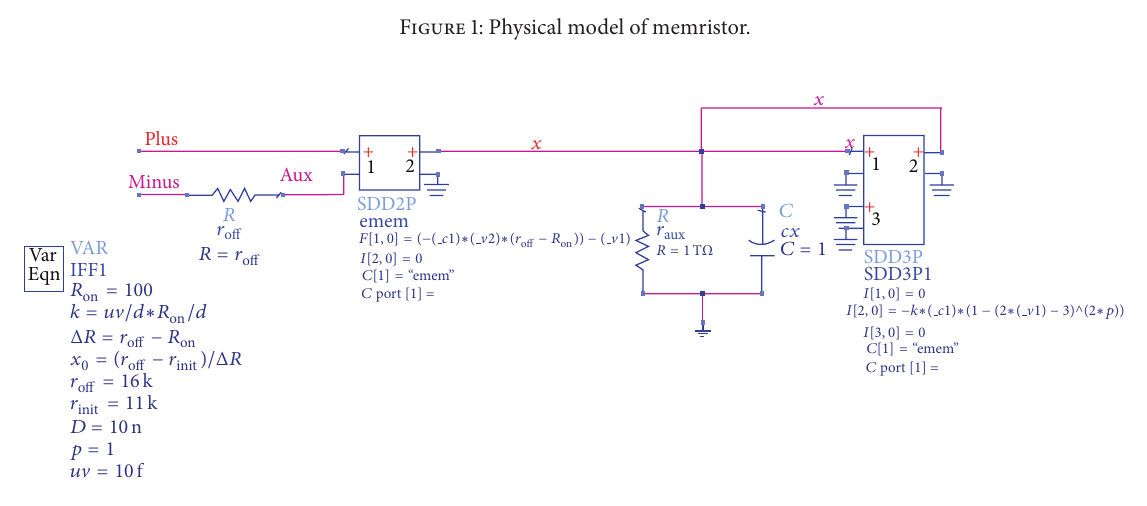
Figure 2: Schematic of the memristor ADS implementation.